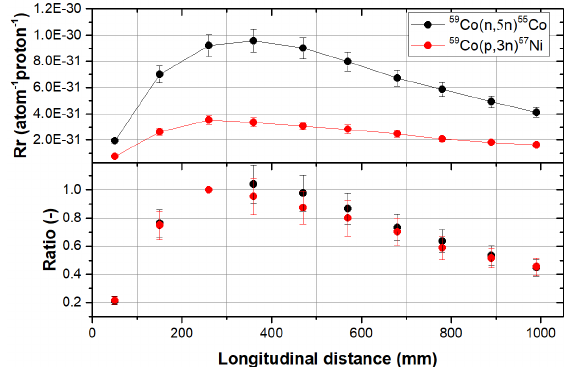
Figure 4. Determination and comparison of 59 Co ( n , 5 n ) 55 Co , and 59 Co ( p , n 3) 57 Ni reaction rates at carbon experiment.